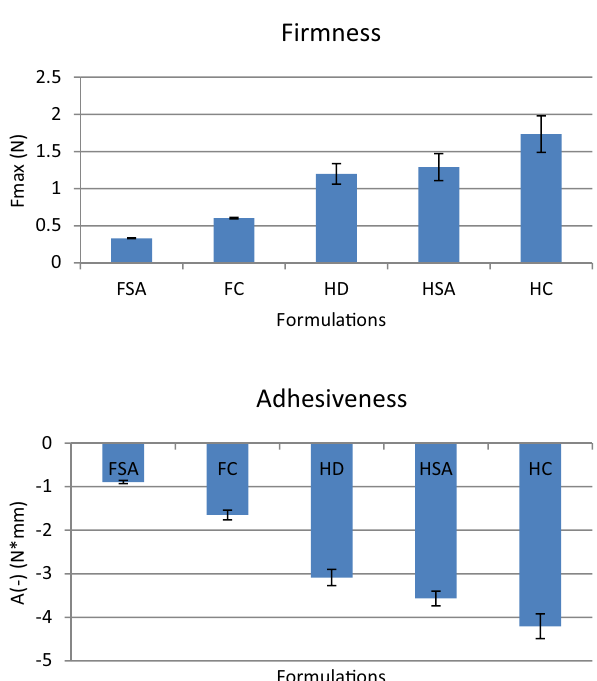
FIGURE 1 – Results of firmness and adhesiveness of the formulations containing dithranol (HD) and solid dispersions of dithranol in stearic acid and argan oil (FSA and HSA) and in glyceryl behenate (FC and HC).